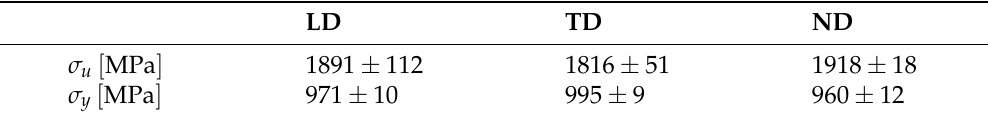
Figure 2. Stress-strain response of WAAM-fabricated Ti-6Al-4V in three orthogonal directions during compression test at 0.1 mm/min. Table 3. Compressive mechanical properties of WAAM-fabricated Ti-6Al-4V in three orthogonal directions. σ u and σ y are ultimate compressive strength and compressive yield strength, respectively. Specimens loaded in normal direction show the highest ultimate compressive strength. The compres- sive Young’s modulus of the WAAM-fabricated Ti-6Al-4V is determined as constant of E c = 120 GPa in all three different